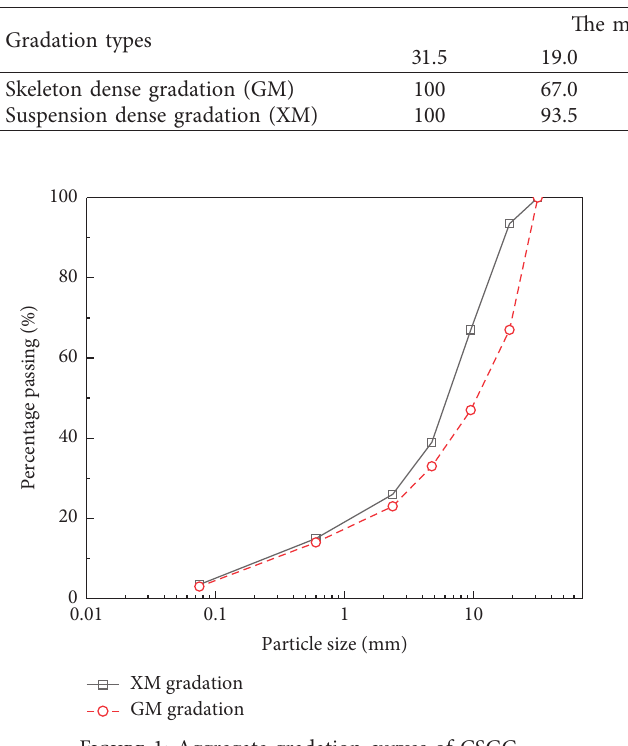
Table 3: Mineral aggregate gradation.